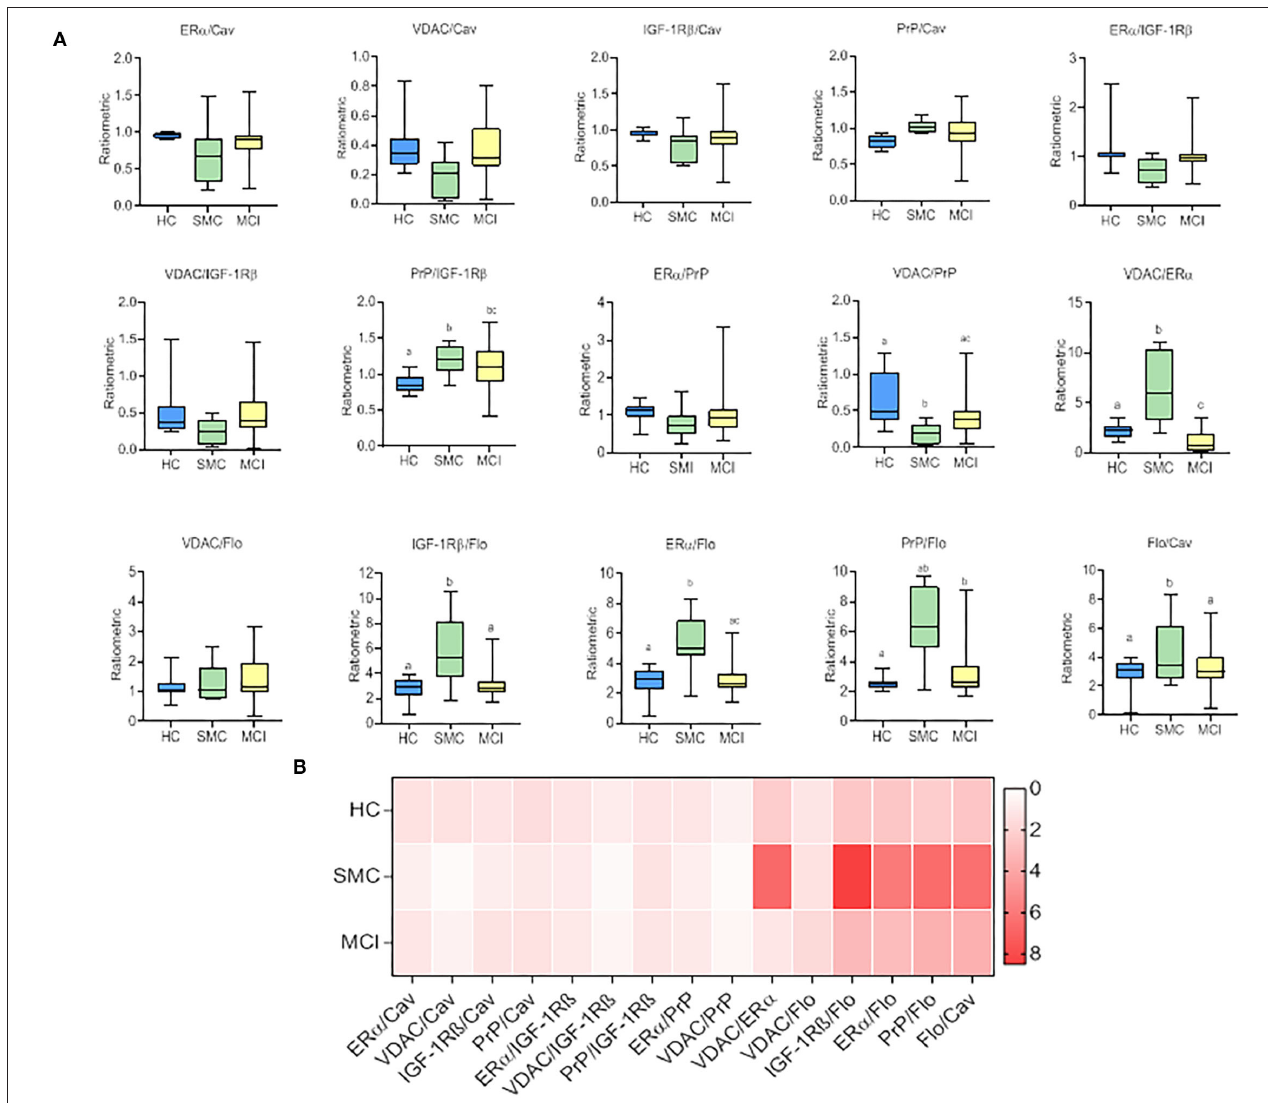
FIGURE 3 | The box plots for signalosome protein ratios (A) in the CSF of HC, SMC and MCI groups. The data were submitted to one-way ANOVA or Kruskal–Wallis test followed by post-hoc Tukey’s HSD test, Games–Howell or Mann–Withney U -test where appropriate. The different letters in each plot indicate statistically significant differences with p < 0.05. (B) Heatmap representation of mean protein ratios in the three groups (B) .